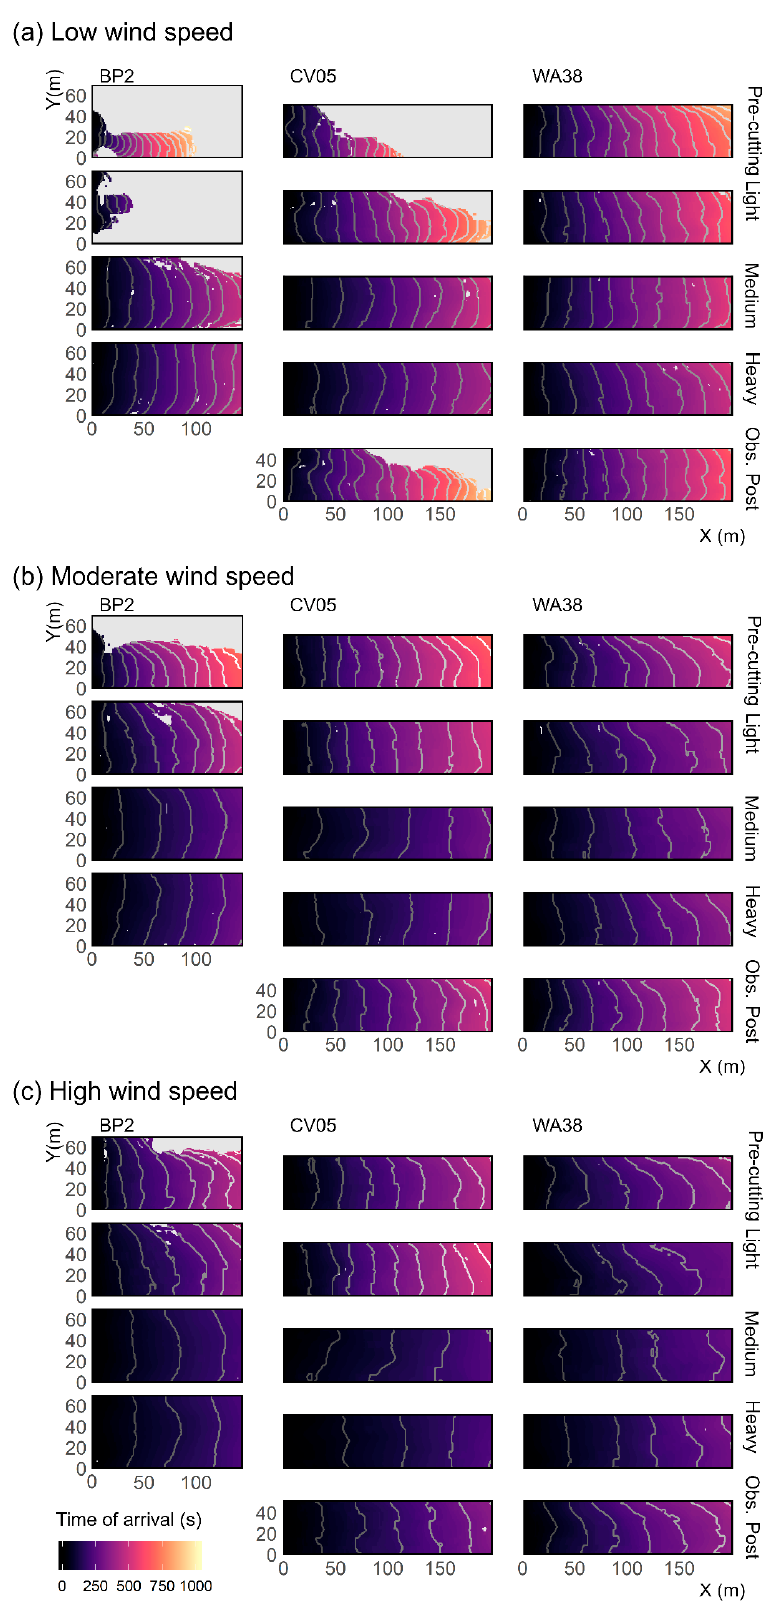
Figure 3. Maps of fire spread (from left to right) among each site and cutting scenario under ( a ) low, ( b ) moderate, and ( c ) high open wind speeds. Contours are time of arrival at 60 s intervals.